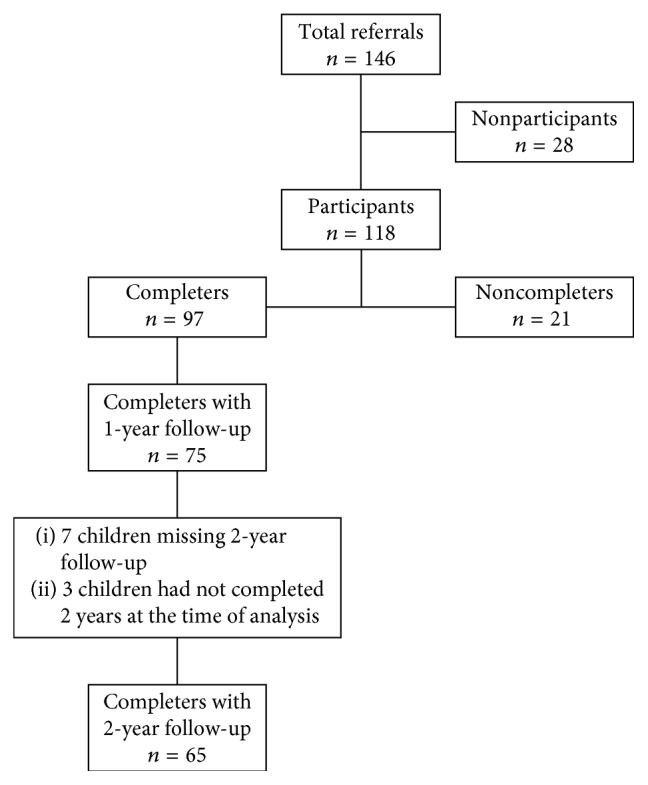
Study flowchart.